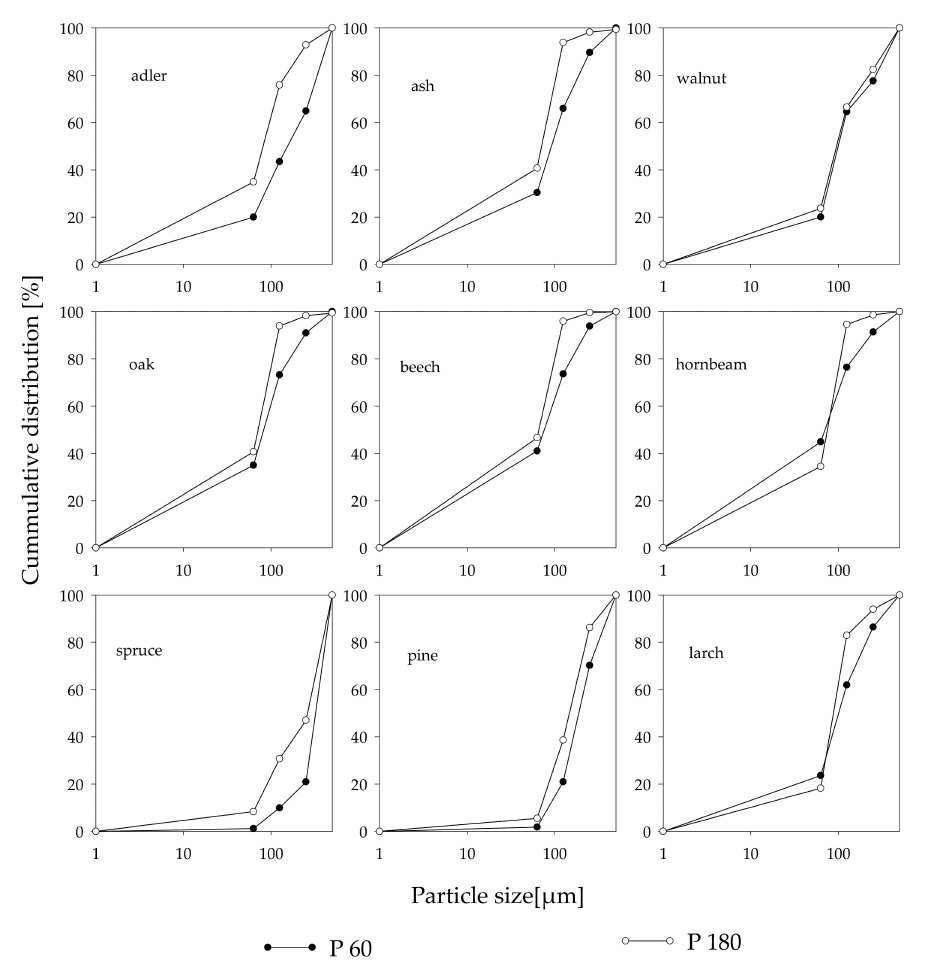
Figure 2. Particle size distributions of wood